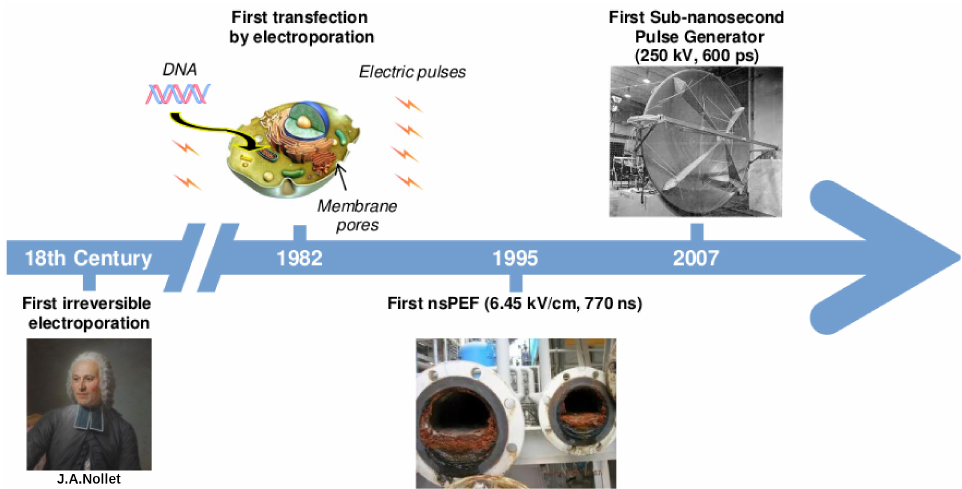
Figure 1. Timeline of main events in the development of electric pulse technology. The first application of electric pulses was recorded in 1754 with the experiments performed by J. A. Nollet. Two centuries later, in 1982, E. Neumann et al. [2] coined the term electroporation to describe the use of electric pulses to create membrane pores allowing the insertion of genetic material into cells. Afterwards, in 1995, Schoenbach et al. [12] developed the first nsPEF technology to prevent biofouling of cooling systems. Lately, the construction of an IRA in 2007 by Heeren et al. [13], allowed the application of sub-nanosecond